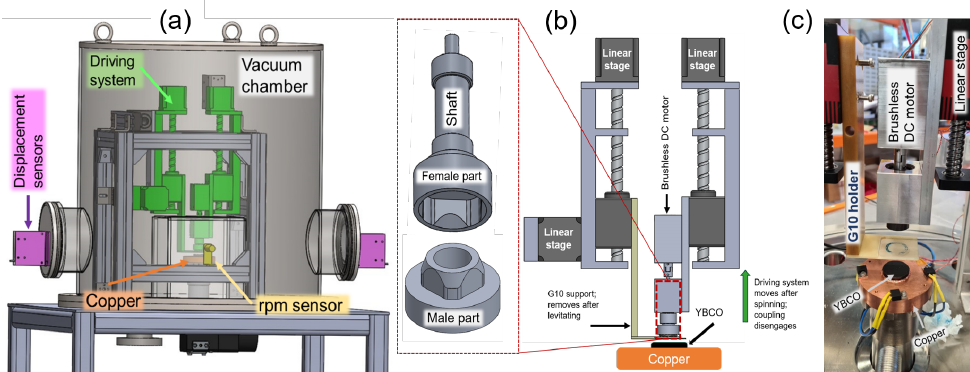
Figure 1. Schematic demonstration of the test rig ( a ), the driving system ( b ), and a photo of the driving system ( c